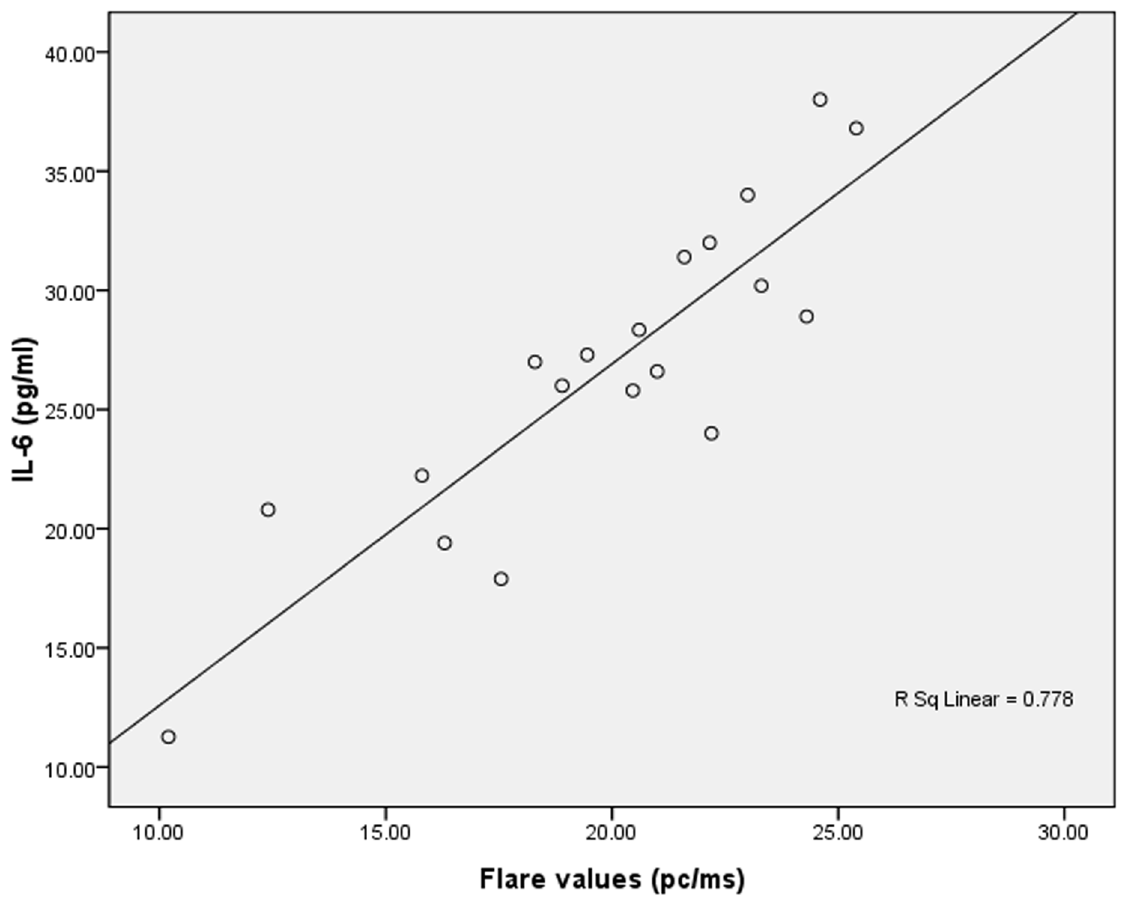
Figure 2. Correlation between the IL-6 levels in the AqH and the preoperative flare values in the VKH and BD patients. doi:10.1371/journal.pone.0109647.g002 PLOS ONE |